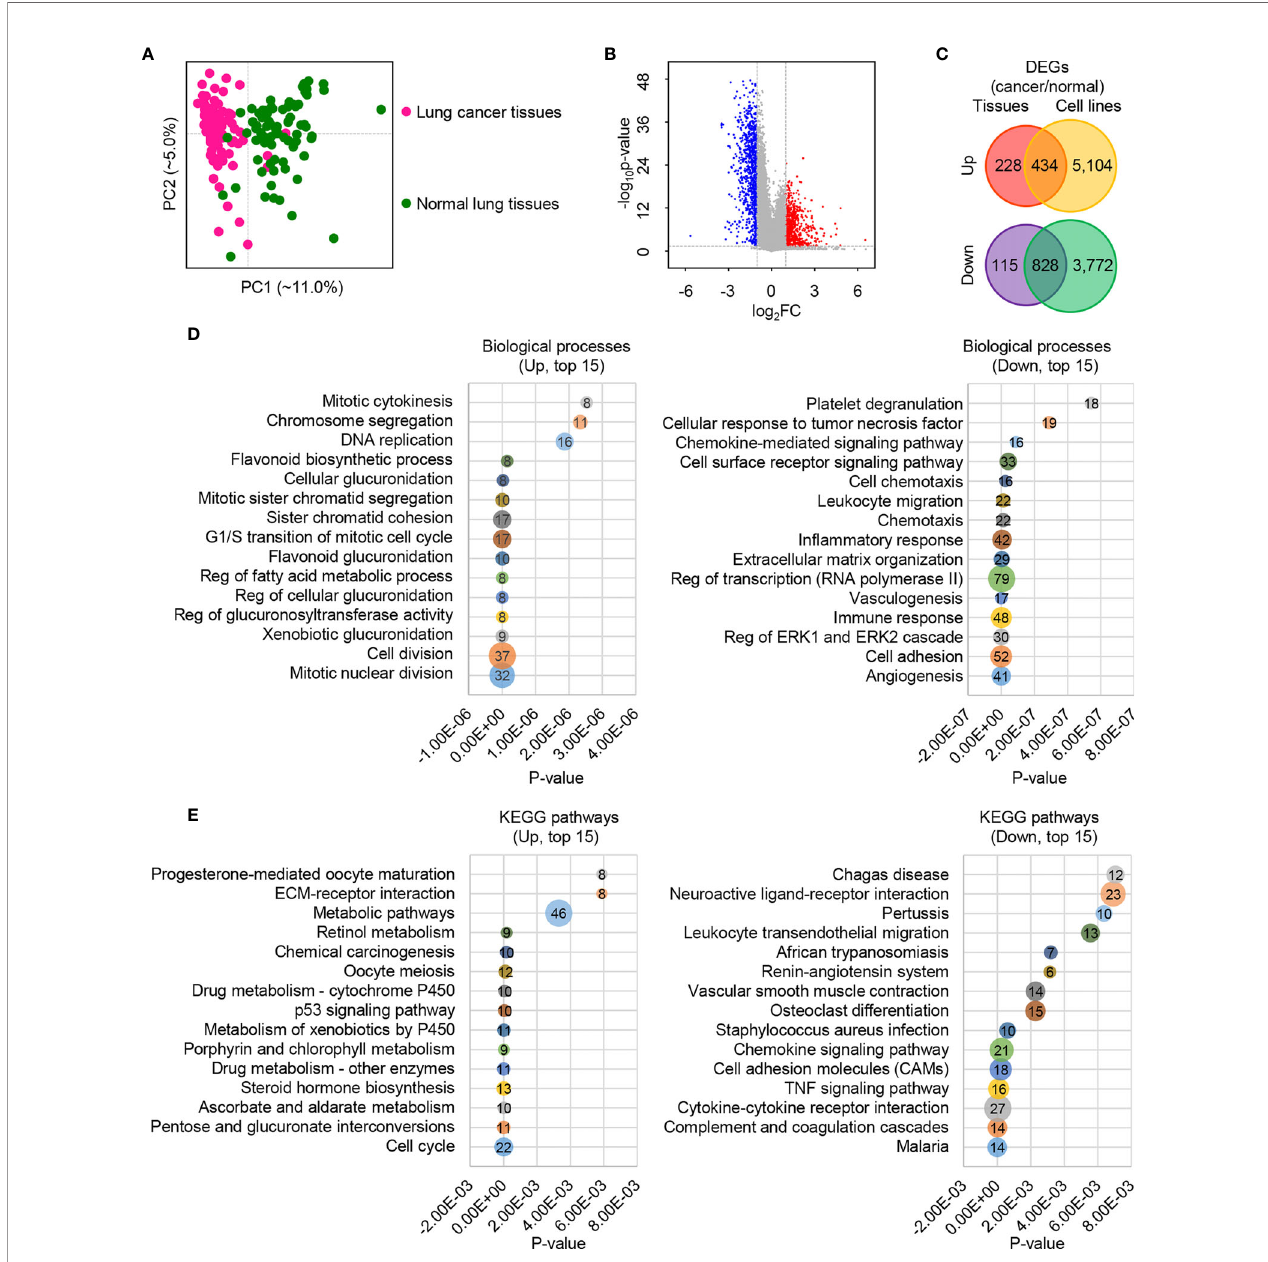
FIGURE 1 | The global expression pro fi les of human lung cancer cells/tissues and adjacent lung normal cells/tissues. (A) The fi rst two principal components plot of LUAD tissues via PCA. (B) Volcano plot of genes between human lung cancer tissues and adjacent lung normal tissues. The absolute FC of ≥ 2.0 and p -value of ≤ 0.05 were used. (C) Venn diagram plot of DEGs based on tissues and cells with the absolute FC of ≥ 2.0 and p -value of ≤ 0.05. (D) Bubble diagram plot of the top 15 enriched biological processes for the upregulated (left) and downregulated (right) DEGs. (E) Bubble diagram plot of the top 15 enriched KEGG pathways for the upregulated (left) and downregulated (right)